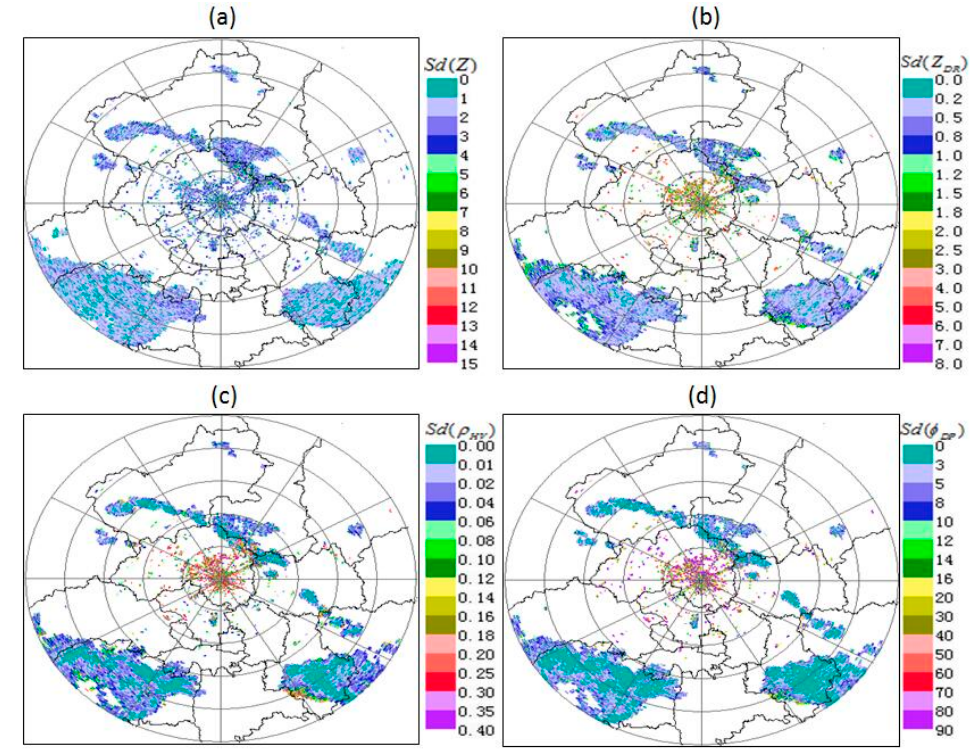
Φ ρ DR ), ( c ) Sd( HV ), and ( d ) Sd( DP